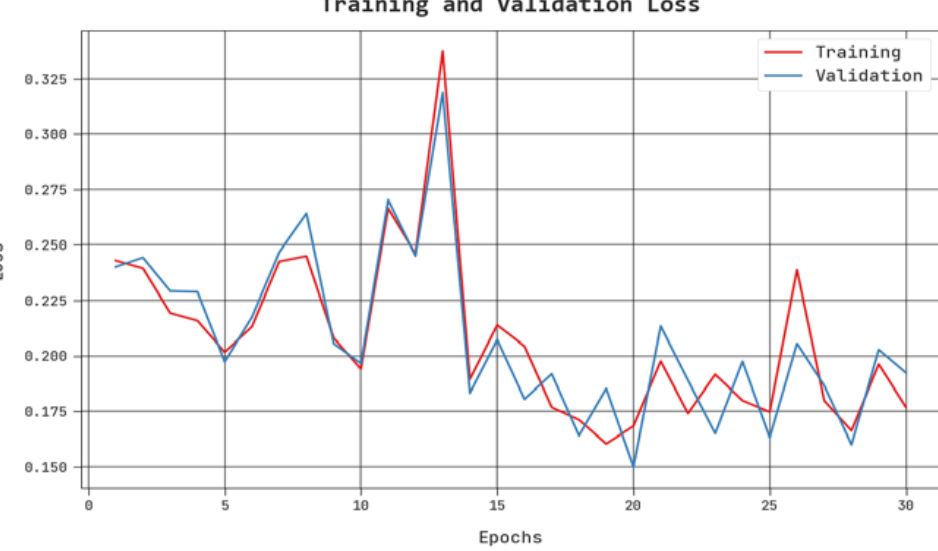
Figure 8. TACC and VACC analysis of PPIE-ODLASC approach.